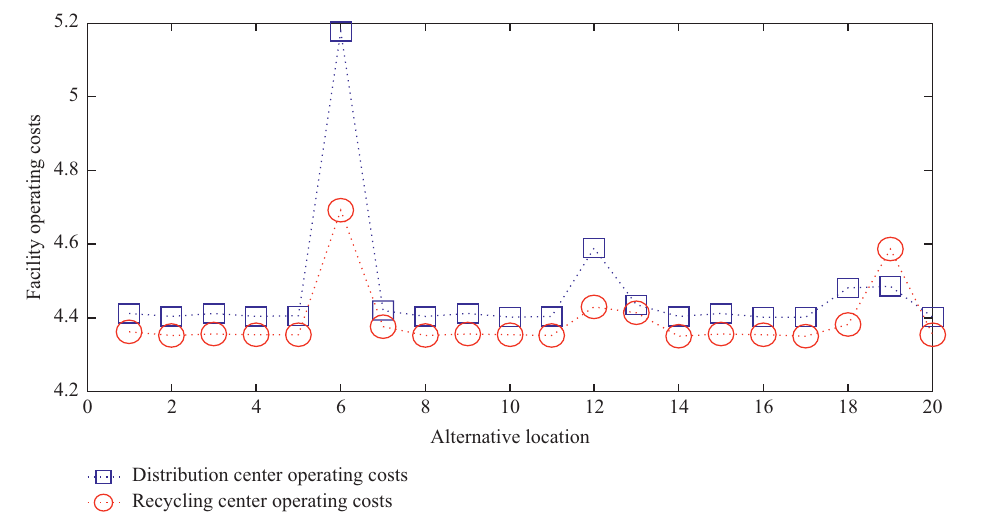
Figure 5: Operating costs of various types of logistics facilities at alternative locations.